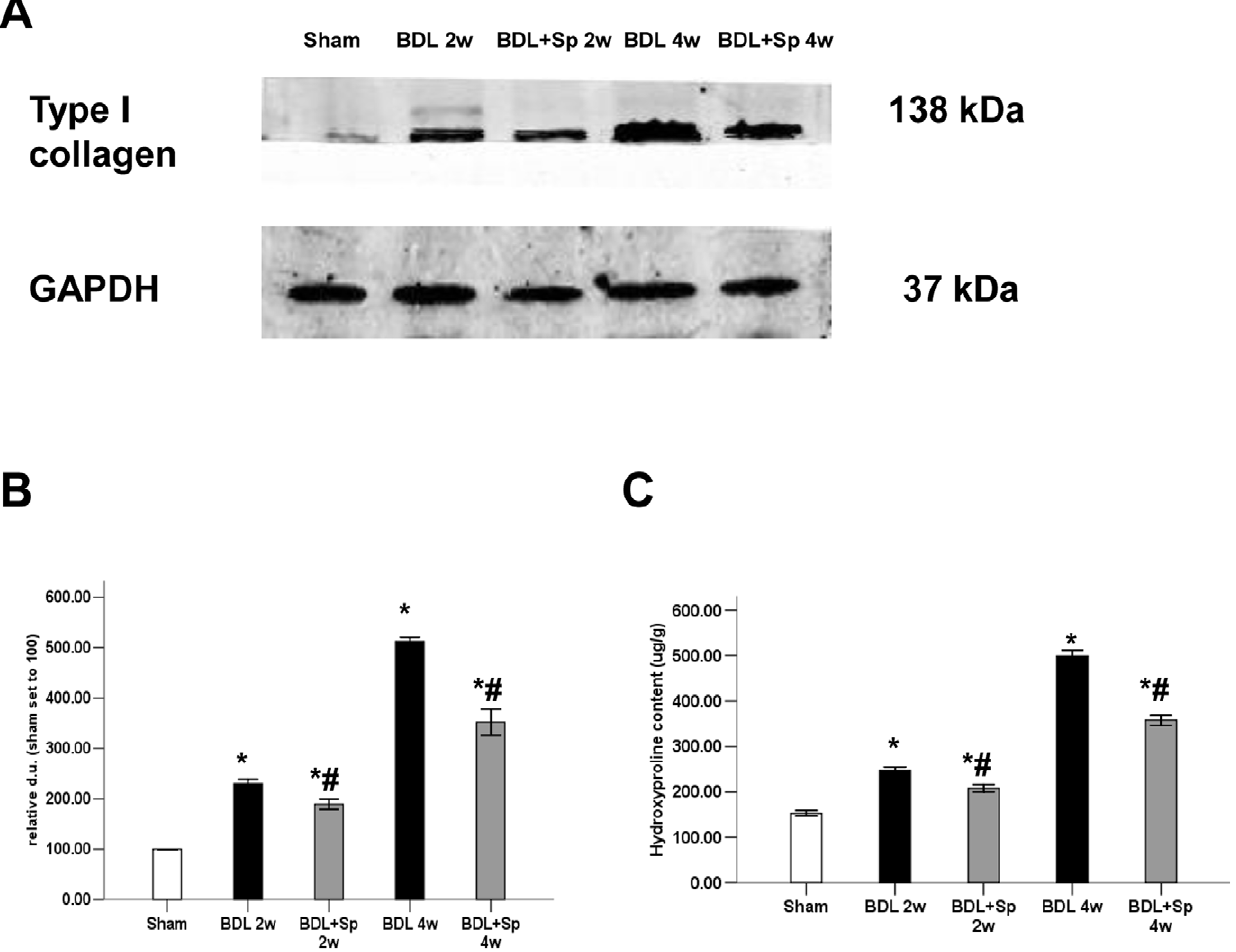
Figure 2. Spironolactone (Sp) downregulates type I collagen expression and reduces hydroxyproline content in BDL rats. (A) Spironolactone downregulates type I collagen protein expression in the livers of BDL rats, as shown by Western blot analysis (B). Sprionolactone reduces hydroxyproline content in rat livers (C). * p , 0.05 compared to the Sham group. # p , 0.05 compared to the BDL groups. doi:10.1371/journal.pone.0034230.g002 (ANOVA) with Statistical Package for the Social Sciences (SPSS) 13.0 software (Chicago, IL). A probability ( p )-values less than 0.05